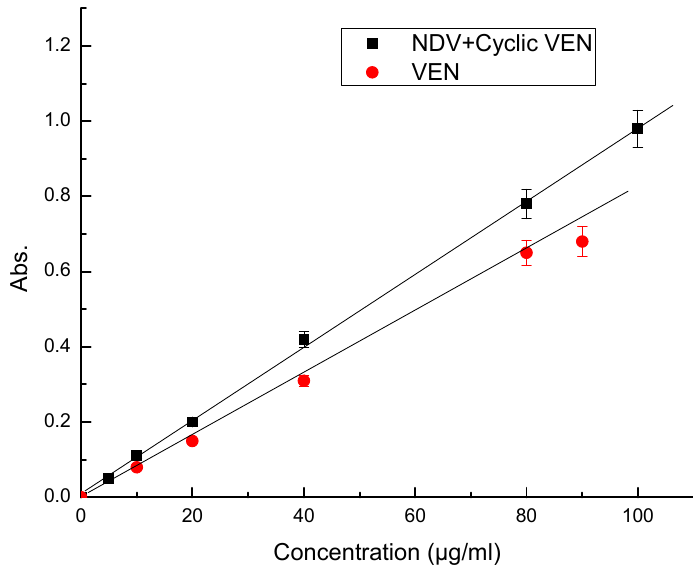
Figure 4. Calibration curves of colored complexes of VEN and mixture of NDV + Cyclic VEN.